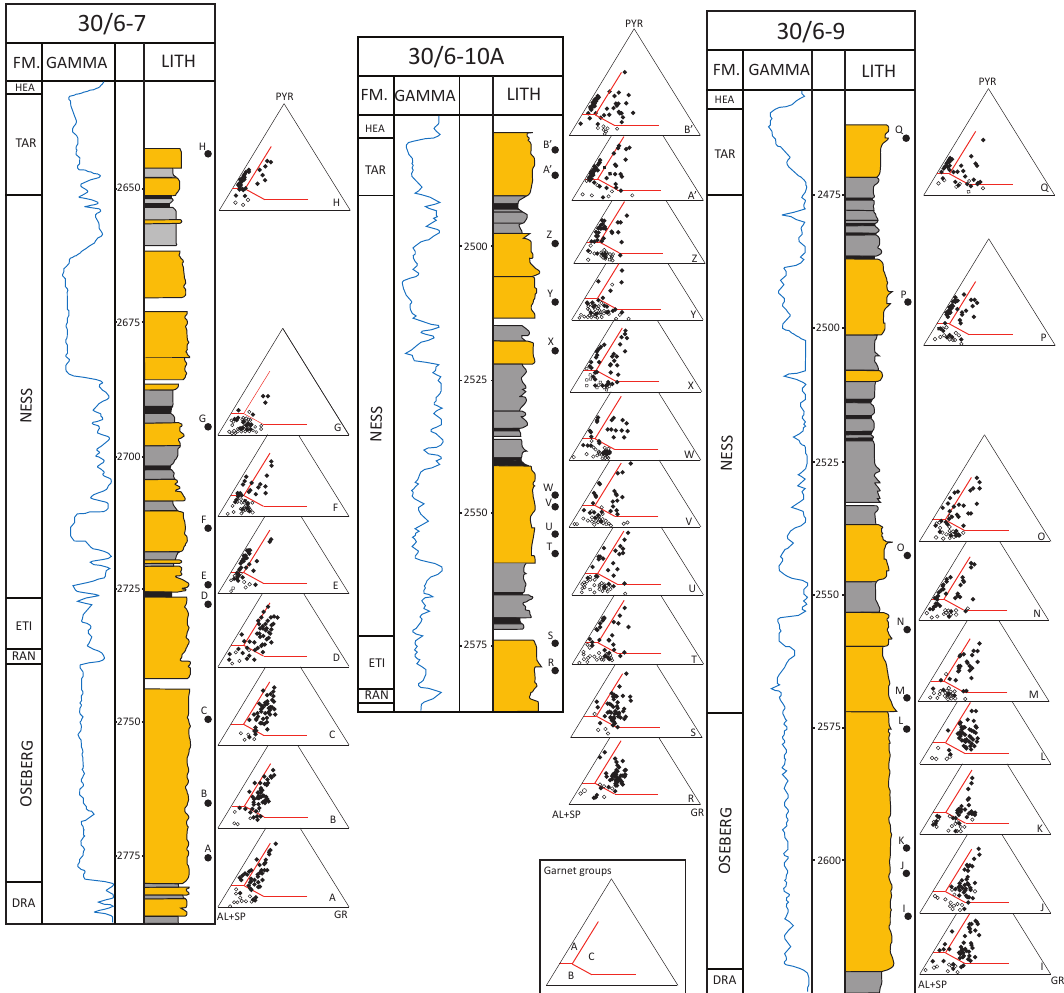
Figure 8. Stratigraphic breakdown and correlation of the Brent Group in Oseberg Fields well 30/6-7, 30/6-9, and 30/6-10A using garnet geochemical signatures. AL = almandine, SP = spessartine, GR = grossular, PYR = pyrope. Garnet fields A, B, and C are as defined by Morton et al. [56] and Mange and Morton [57]. Yellow = sandstone, grey = mudstone, black =